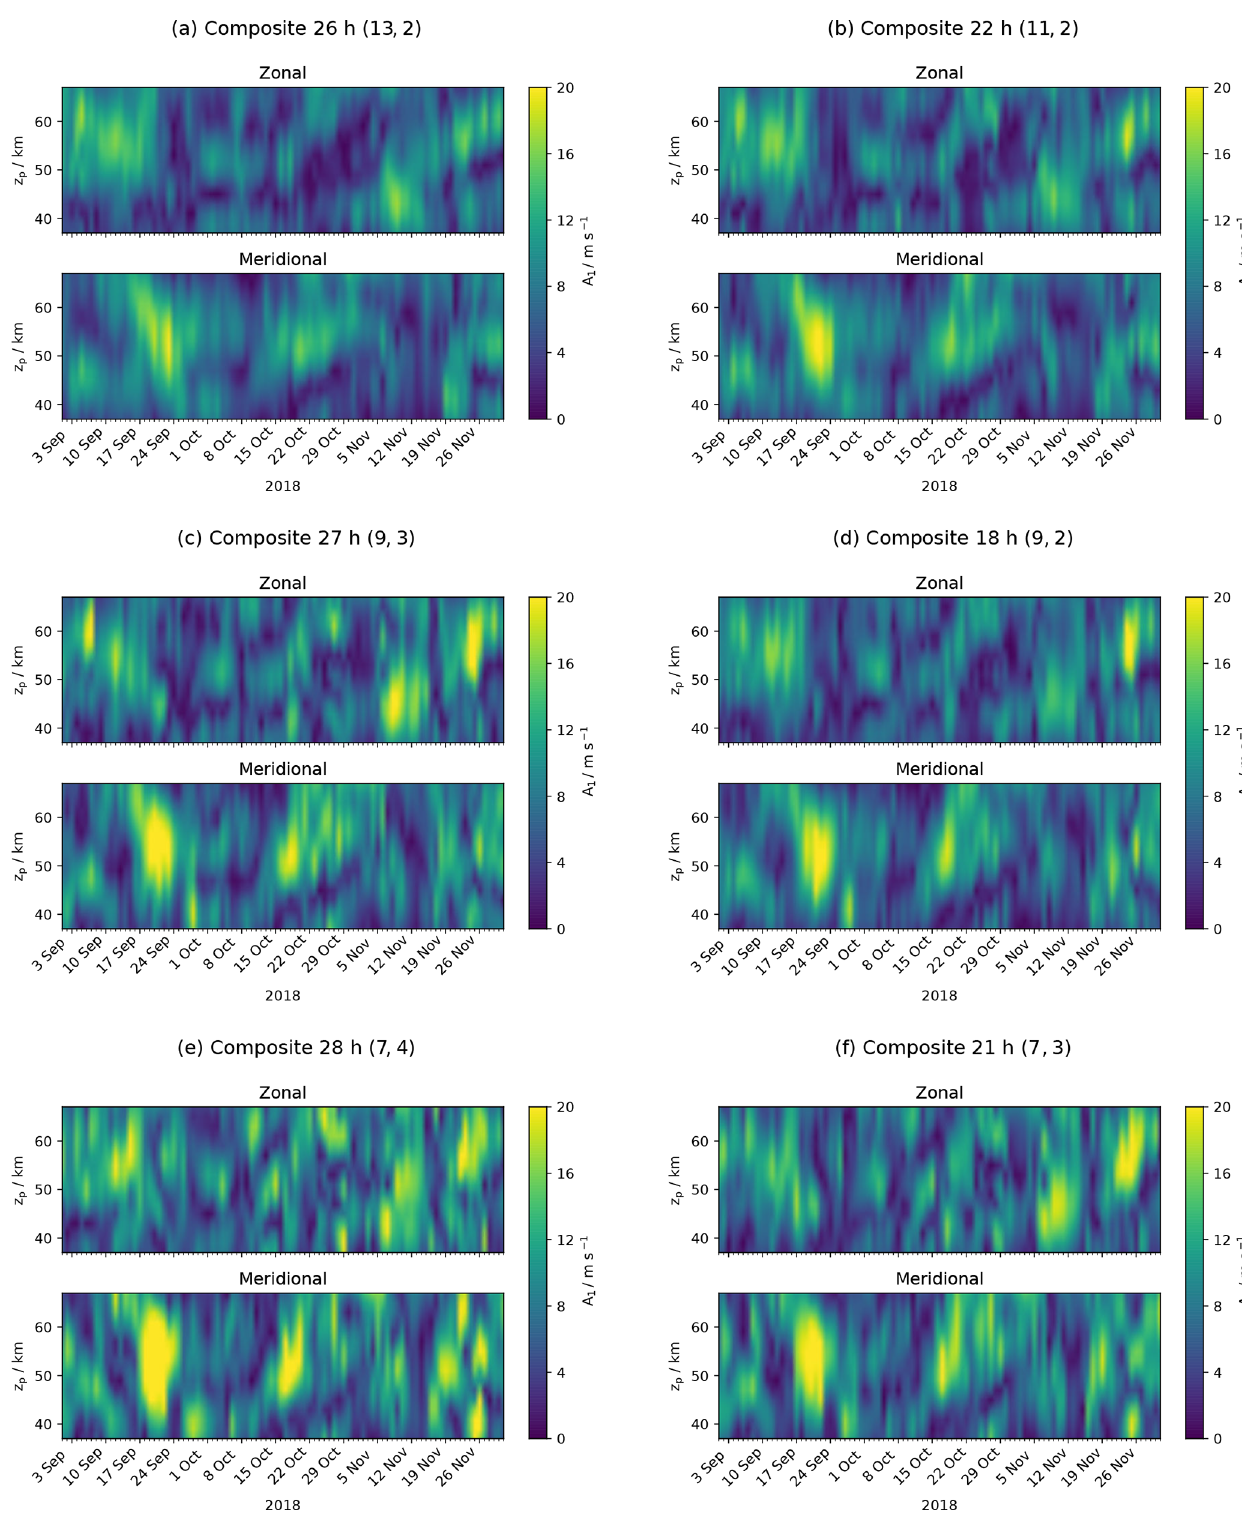
Figure A3. Arctic campaign: amplitude of the diurnal tide for six different composites with a similar total integration time of 21 to 28h ordered by window